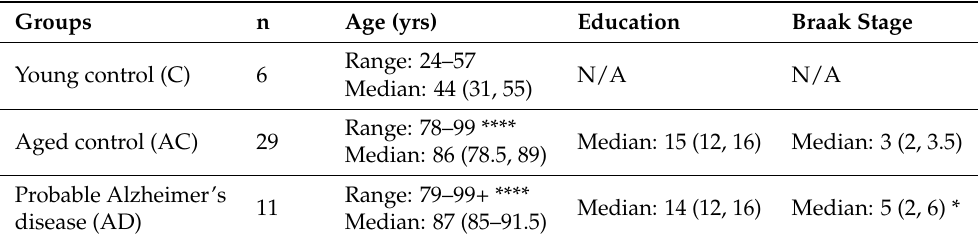
Table 1. Demographic data for human subjects. Age, education and the Braak staging level are shown as median values; numbers in parentheses (1st, 3rd) indicate the 1st and 3rd quartile values. Statistical significant differences between age ranges were evaluated via a non-parametric Mann–Whitney U test; **** indicates p < 0.0001 as compared to the young control group; * indicates p < 0.05 for AD versus the aged control group; n is the number of